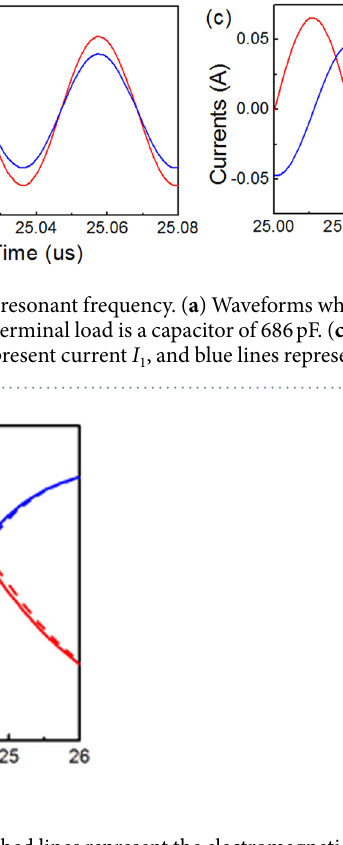
Figure 5. Scattering parameters. Solid and dashed lines represent the electromagnetic and circuit simulation results, respectively. The blue and red lines represent S 11 and S 21 ,